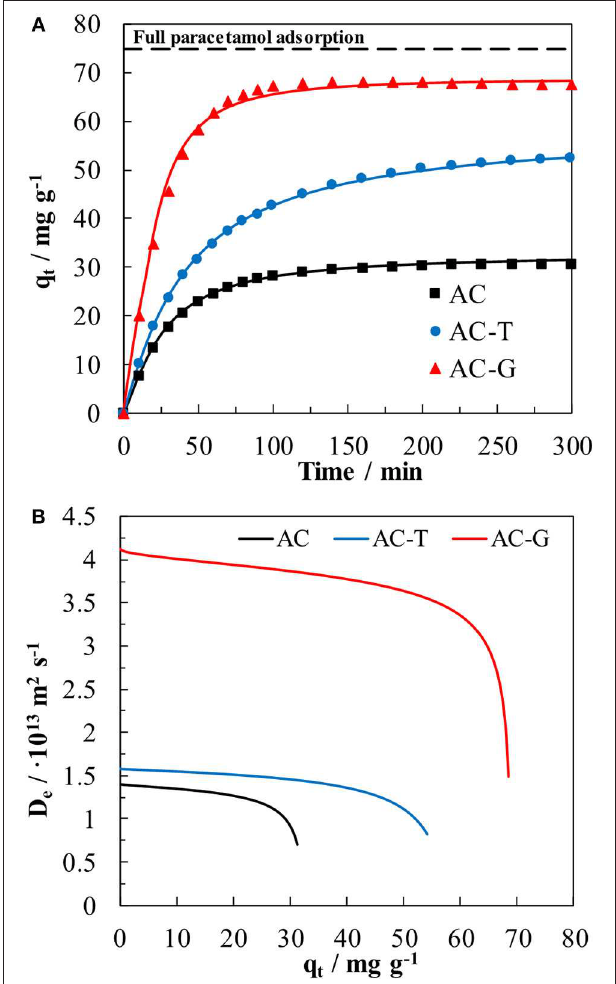
FIGURE 8 | (A) Kinetic plots of paracetamol adsorption on AC, AC-T, and AC-G at 25 ◦ C. (C 0 = 5mg L − 1 ; V = 150mL; w = 100mg L − 1 ). Dots: experimental data, line: hyperbolic fitting. (B) Relationship between the heterogeneous effective diffusion coefficient with qt for the paracetamol adsorption on AC, AC-T, and AC-G derived from Equation